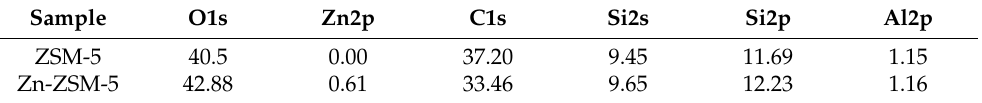
Figure 13. X-ray photoelectron spectroscopy (XPS) survey spectra of ( a ) pure ZSM-5 and Zn-ZSM-5 (Zn/Si = 1:100) and ( b ) Zn 2p in Zn-ZSM-5 composite products (n(Zn)/n(Si) of 1:100). Table 2. Atomic percent accounts of pure ZSM-5 and Zn-ZSM-5 from XPS survey spectra (Unit: